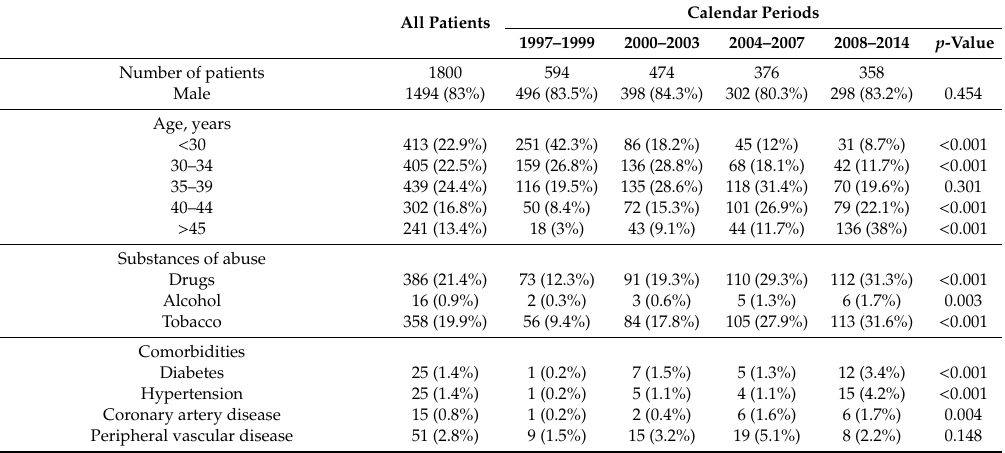
Table 1. Clinical and epidemiological characteristics of hospital admissions of HIV-infected patients with infective endocarditis in Spain (1997 to